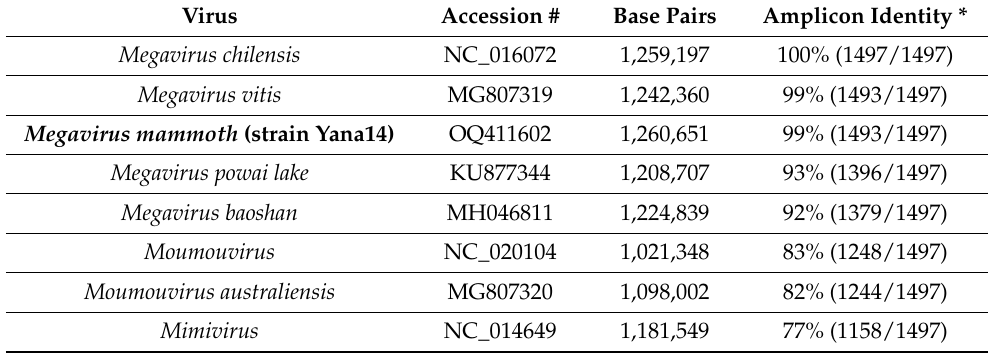
Table 5. PCR identification of Megavirus mammoth (strain Yana14) as a Megavirinae member.